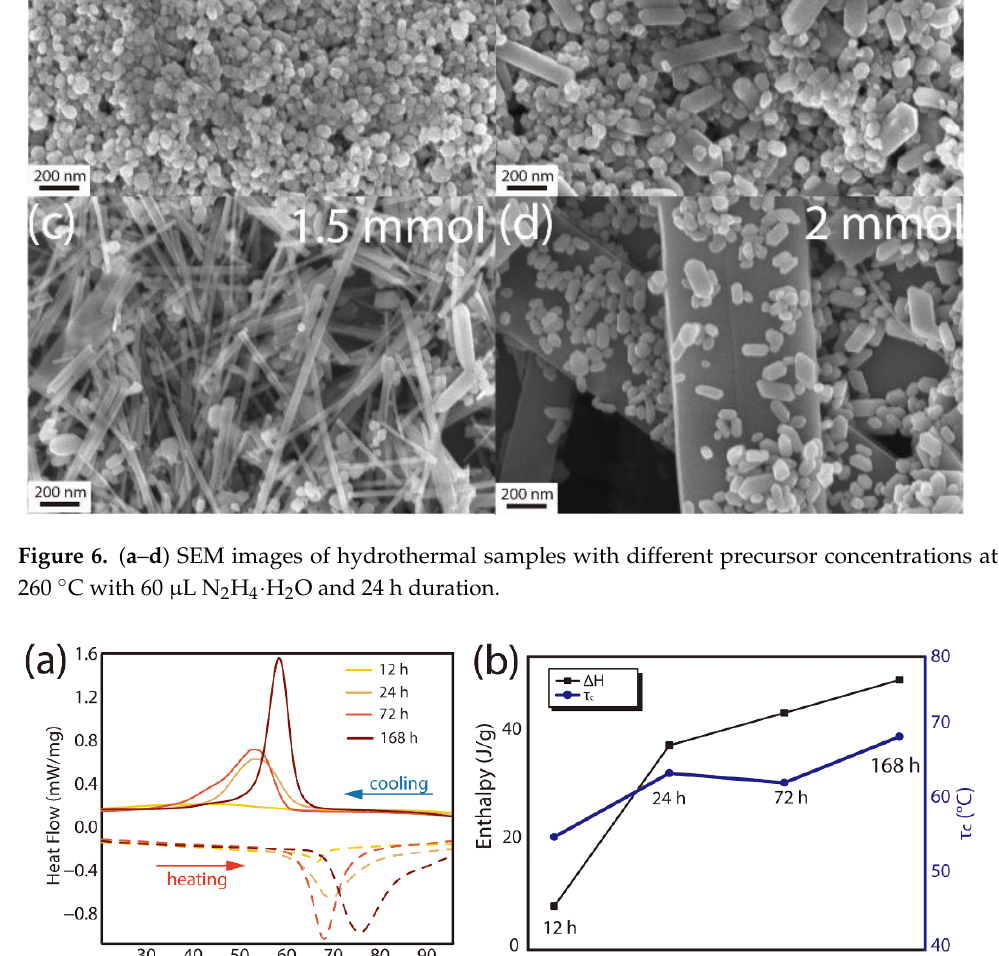
Figure 7. ( a ) Differential Scanning Calorimeter (DSC) curves of the hydrothermal VO 2 powders at different hydrothermal duration at 260 °C with 60 μL N 2 H 4 ·H 2 O; ( b ) phase change enthalpy ( ΔH ) and transition temperature ( τ c ) versus hydrothermal duration.